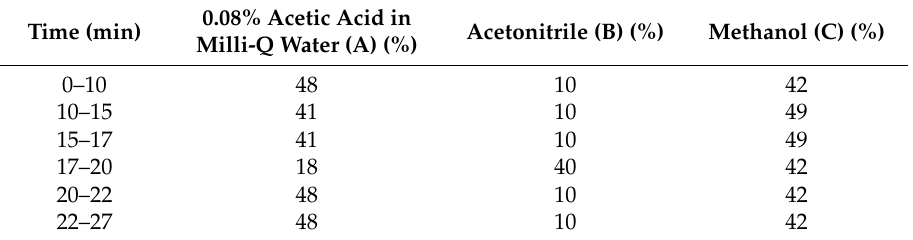
Table 2. Gradient elution of sulfonamides with HPLC-FLD